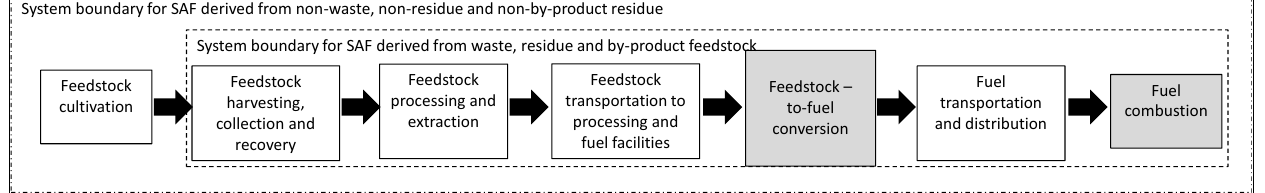
Figure 8. Boundaries in the life-cycle of jet fuel: CORSIA (all) and this study (processes in grey) for the reference scenario.